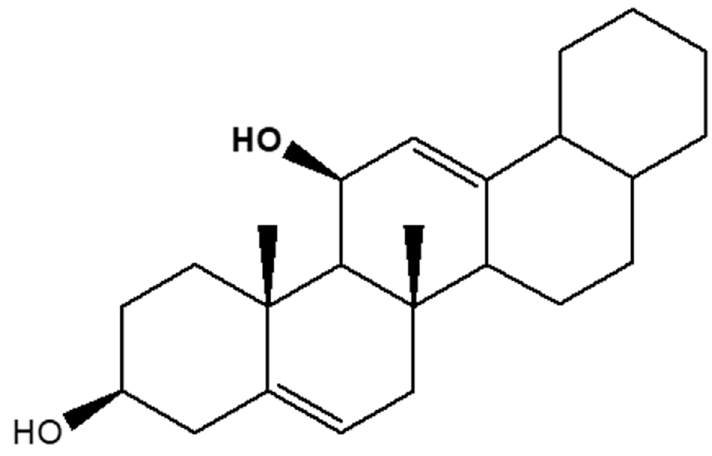
Figure 6. Proposed structure of Ra isolated from the hexane extract of M. oleifera leaves and elucidated as hexademethylated 3 β ,11 β‐ dihydroxyfriedelane.